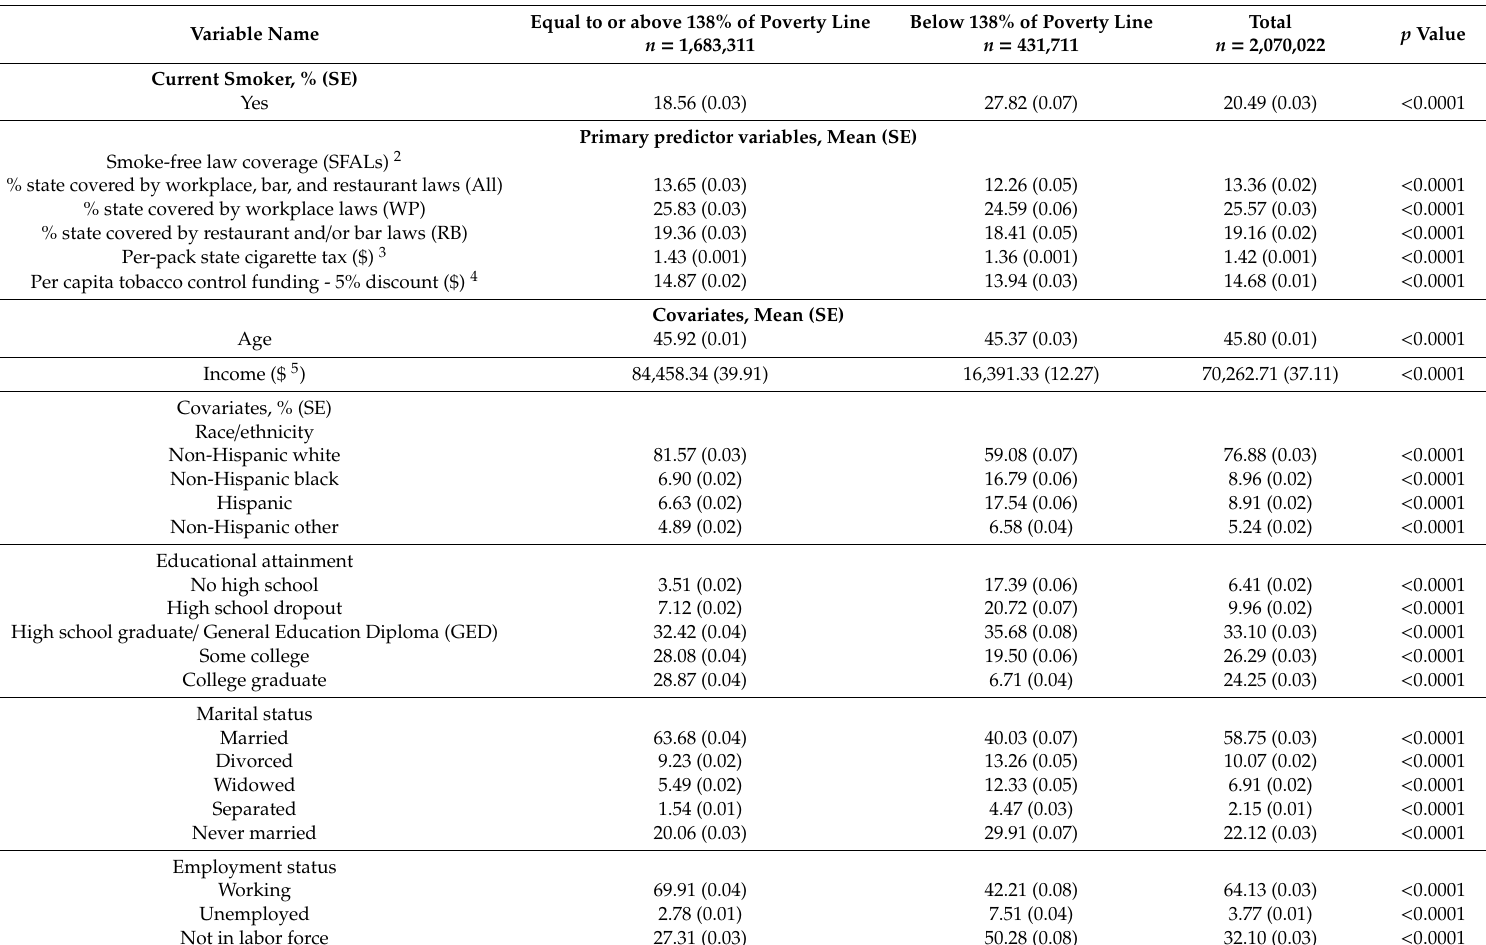
Table 1. Outcome and covariates for the overall U.S. Census Current Population Survey supplement sample (1985–2015) and by poverty status 1